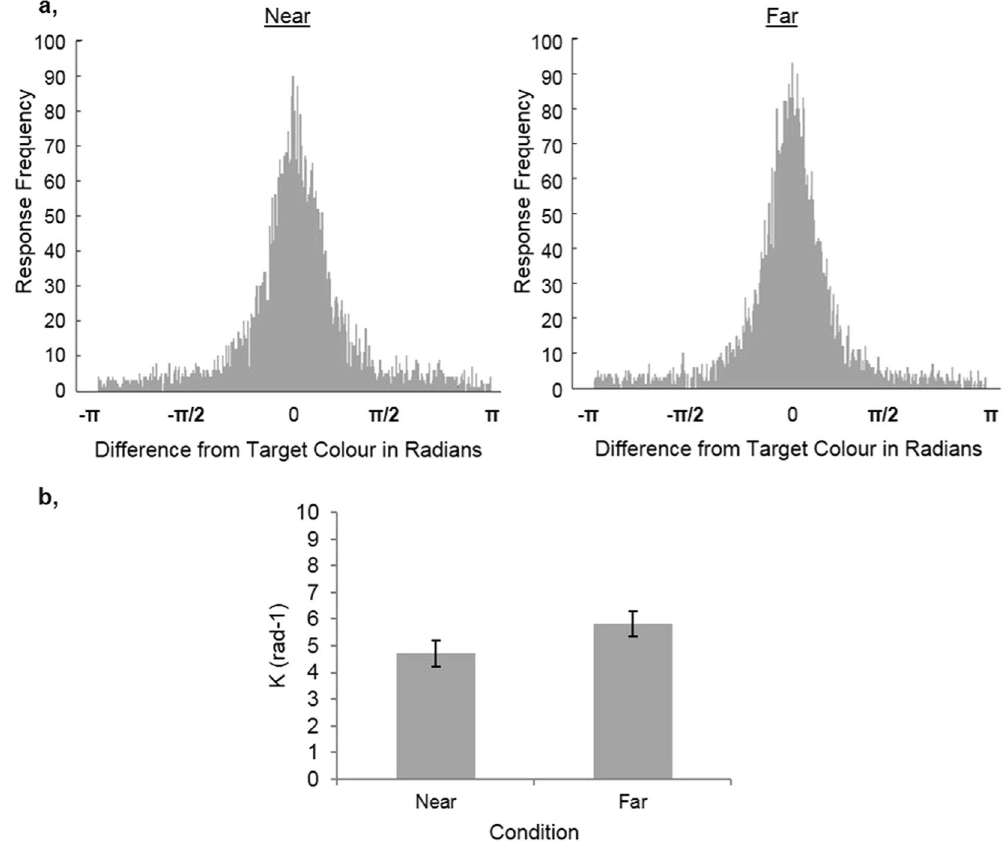
Figure 3. The results of Experiment 1. ( a ) The distribution of responses relative to the target colour (shown at 0 radians) for the Near and Far conditions, pooled across participants. ( b ) The mean precision estimates (K) for each condition, calculated using the mixture model outlined by Bays, Catalao, & Husain 15 . Error bars indicate the standard error of the mean. * Indicates p < 0.05 for the paired t-test between Near and Far conditions.